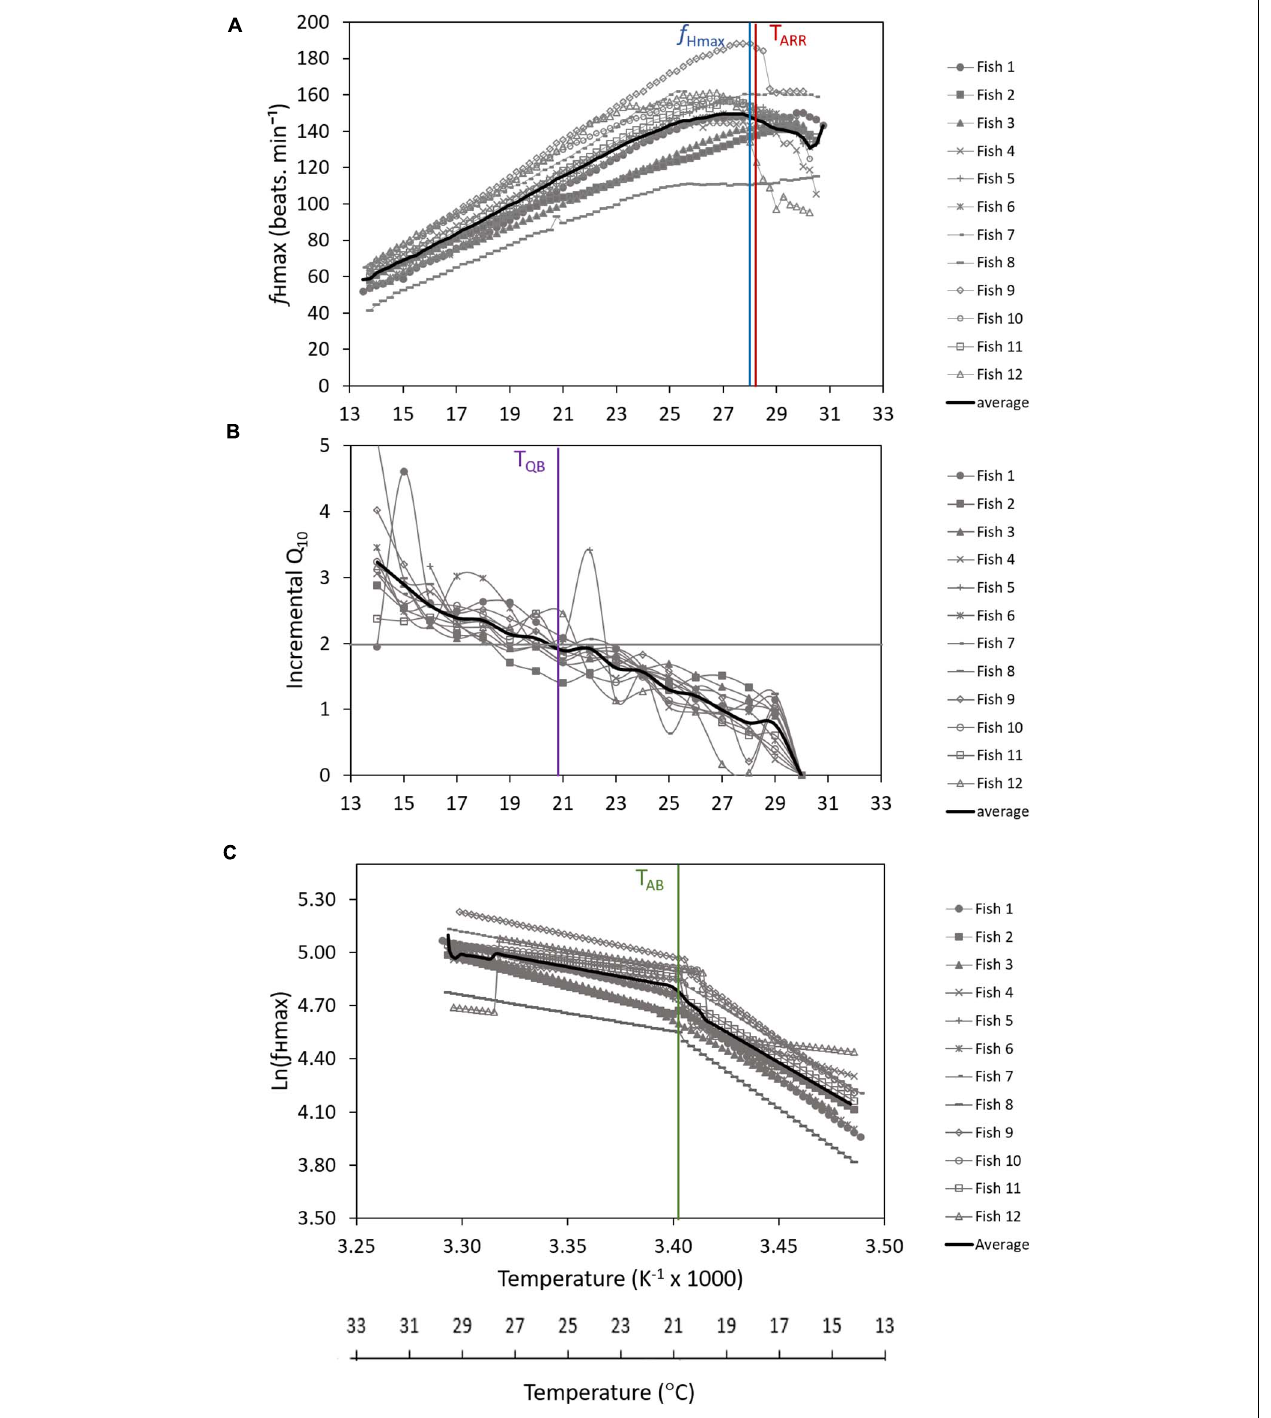
FIGURE 3 | Maximum heart rate ( f Hmax ) (A) , incremental Q 10 analysis of f Hmax for 1.0 ◦ C increments (B) , and Arrhenius plots of natural log of maximum heart rate [ln ( f Hmax )] against the inverse temperature in Kelvin (1,000 K − 1 ) (C) of twelve adult Diplodus capensis in response to increasing water temperature from 14.0 ◦ C. The blue vertical line represents the average maximum heart rate ( f Hmax = 152 beats min − 1 at 28.0 ◦ C). The red vertical line represents the average arrhythmic temperature (T ARR = 28.3 ◦ C). The gray horizontal solid line represents the average Q 10 breakpoint (Q 10 < 2.0). The purple vertical line represents the incremental Q 10 breakpoint temperature (T QB = 21.0 ◦ C). The green vertical line represents the average Arrhenius breakpoint temperature (T AB = 20.8 ◦ C).